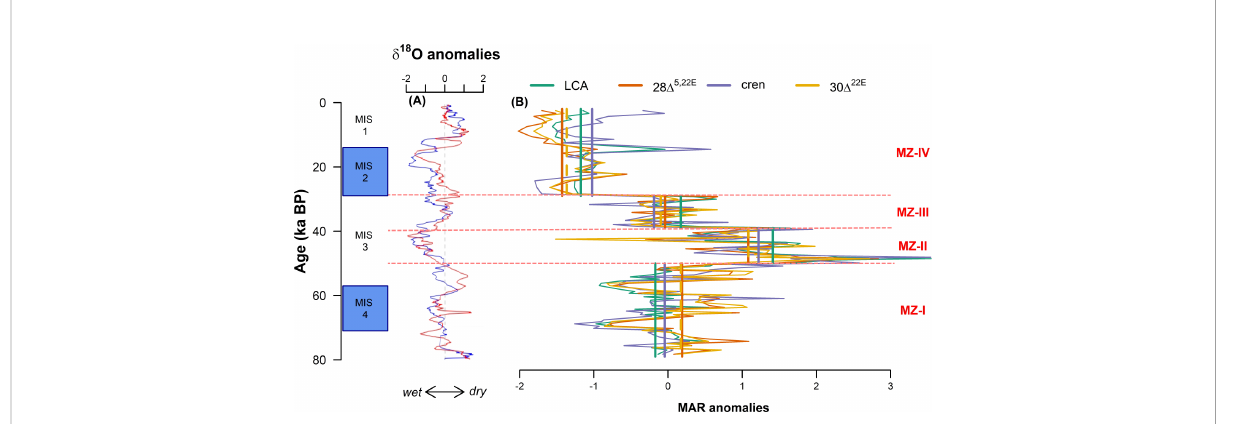
FIGURE 6 (A) Anomalies of d 18 O from the Botuvera ́ and Santana caves (Cruz et al., 2005; Cruz et al., 2007) and (B) anomalies of the mass accumulation rates (MAR) of long-chain alkenones (LCA), 28 D 5,22E , crenarchaeol (cren), and 30 D 22E from the sediment core NAP 63-1. MZ, marine zone. Bold straight lines in (B) refer to the average of each proxy for each